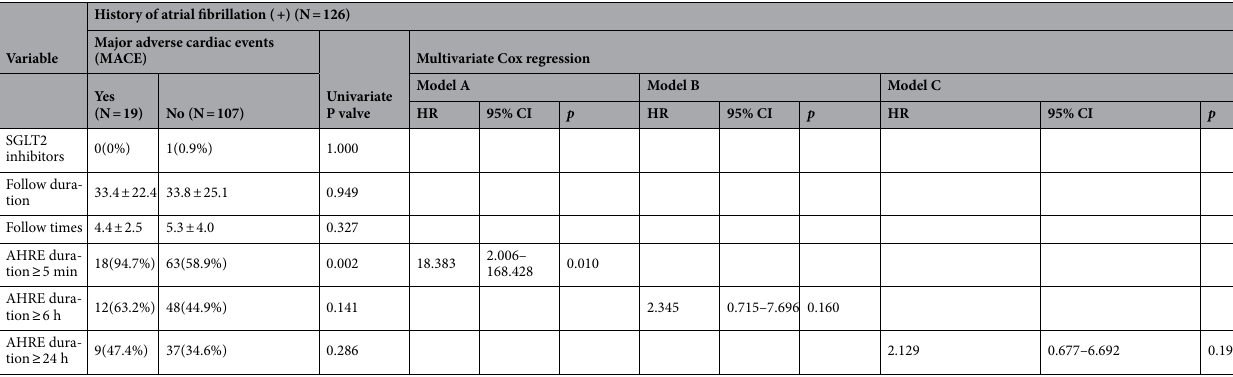
Table 5. Cox proportional hazard regression analysis with time-dependent covariates for MACE predictors in patients with history of atrial fibrillation and with AHREs ≥ 5 min (Model A), ≥ 6 h (Model B), ≥ 24 h (Model C). Data are presented as mean ± SD or median, IQR or n (%). AF atrial fibrillation, AHRE atrial high-rate episodes, BMI body mass index, EF ejection fraction, IQR interquartile range, LA left atrium, LVEF left ventricular ejection fraction, RV right ventricle, non-DHP CCBs non-dihydropyridine calcium channel blockers, RAAS renin–angiotensin–aldosterone system, SGLT2 sodium glucose co-transporters